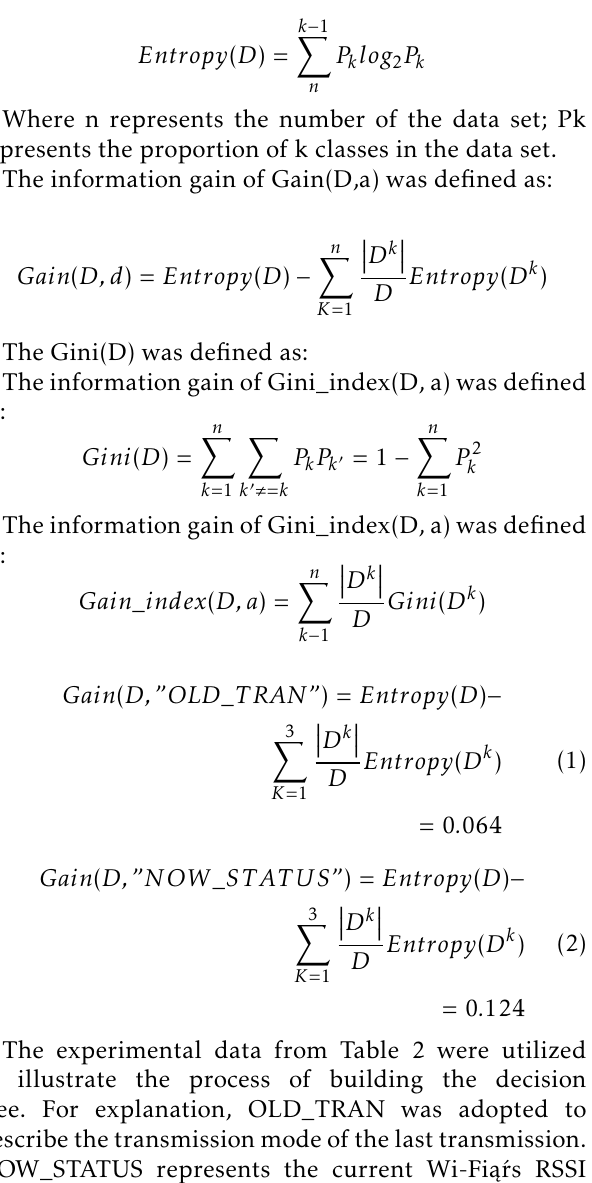
Implementation of Decision Tree Classification. To